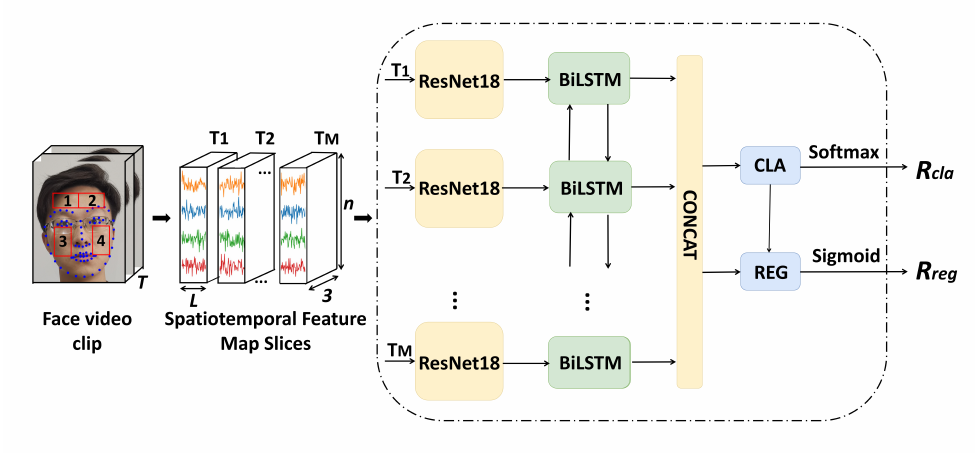
Figure 1. An overview of our blood pressure estimation network. We first generate the corresponding spatiotemporal feature map slices of the input facial video clips. Then, a feature extractor composed of a depth residual network and BiLSTM fits a high-dimensional feature, which is fed into the blood pressure classifier to locate the blood pressure interval through this feature. Finally, the blood pressure calculator combines the results of the feature extractor and the blood pressure classifier to output the final blood pressure